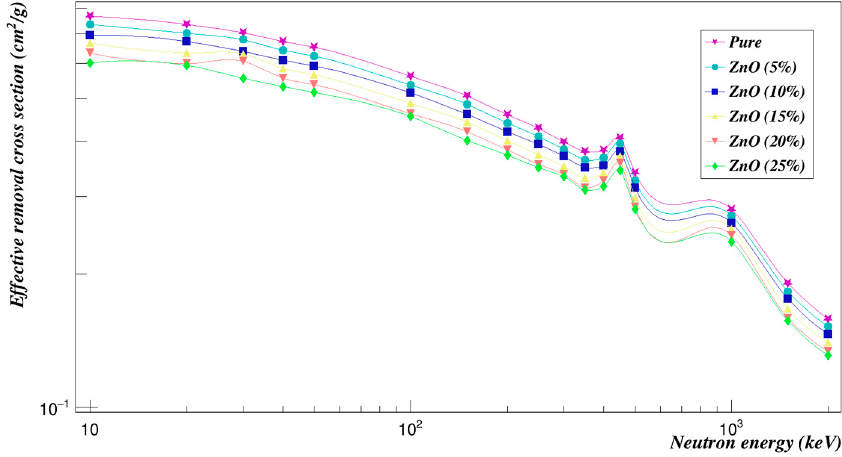
Figure 9. Neutron e ff ective removal cross sections of Polyimide doped with zinc oxide.